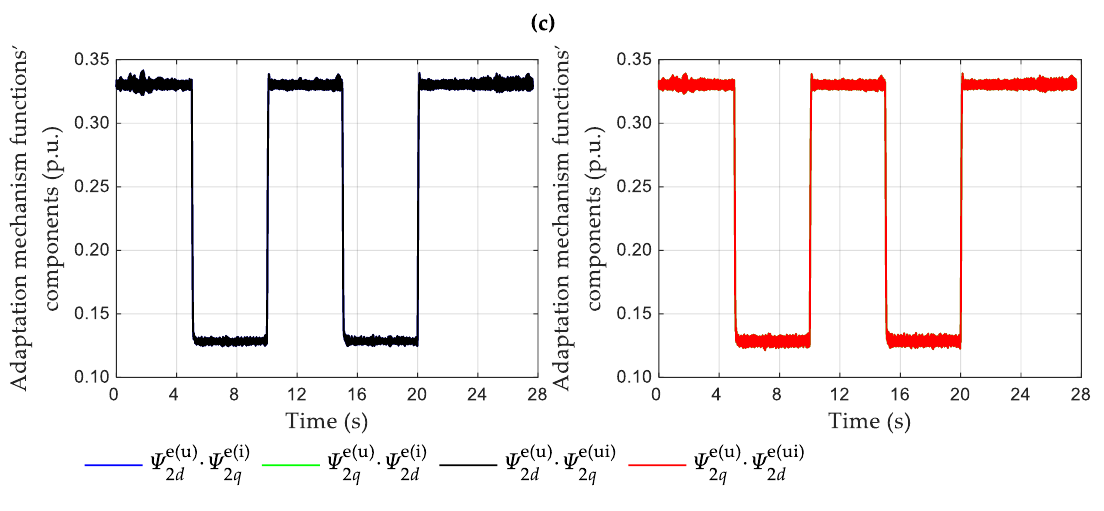
Figure A3. The components of the adaptation mechanism functions returned by the MRAS (u-i) and MRAS (u-ui) during the speed estimation of the tested CR IM: ( a ) the MRAS (u-i) , N = 1 — set B1 parameters; ( b ) MRAS (u-ui) , N = 1 — set B1 parameters; and ( c ) MRAS (u-ui) , N = 2 — set B3 parameters.